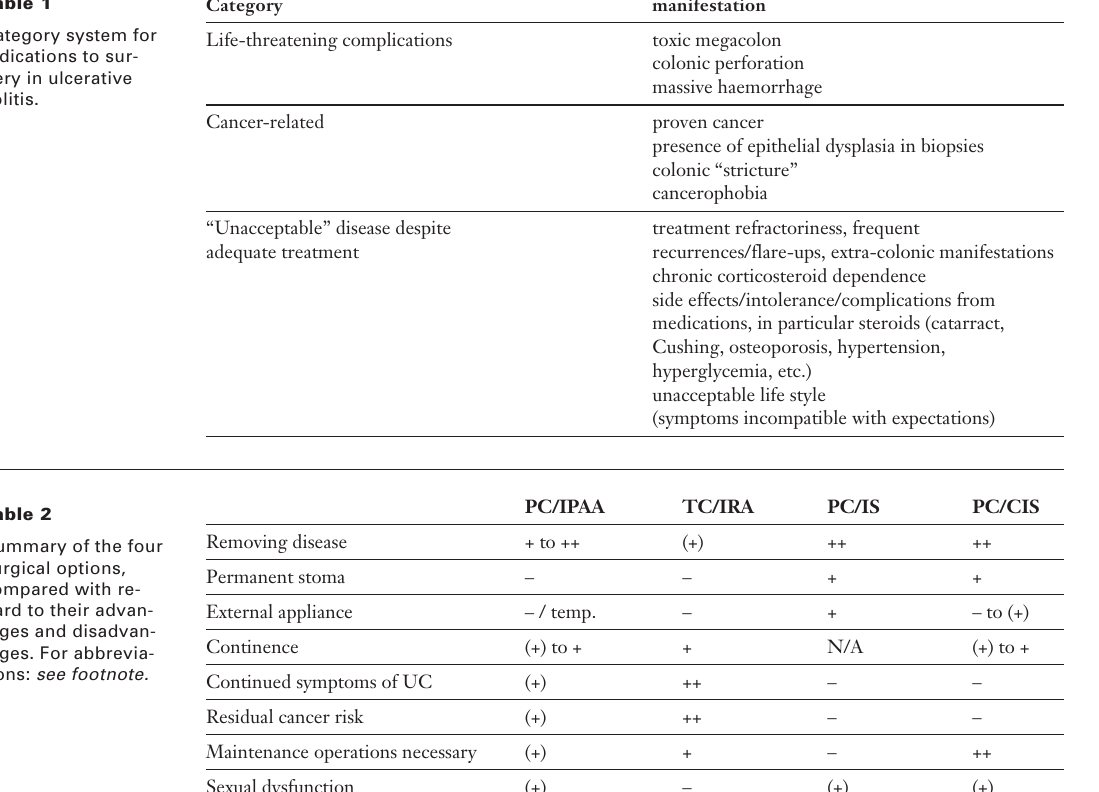
Category system for indications to sur- gery in ulcerative colitis.